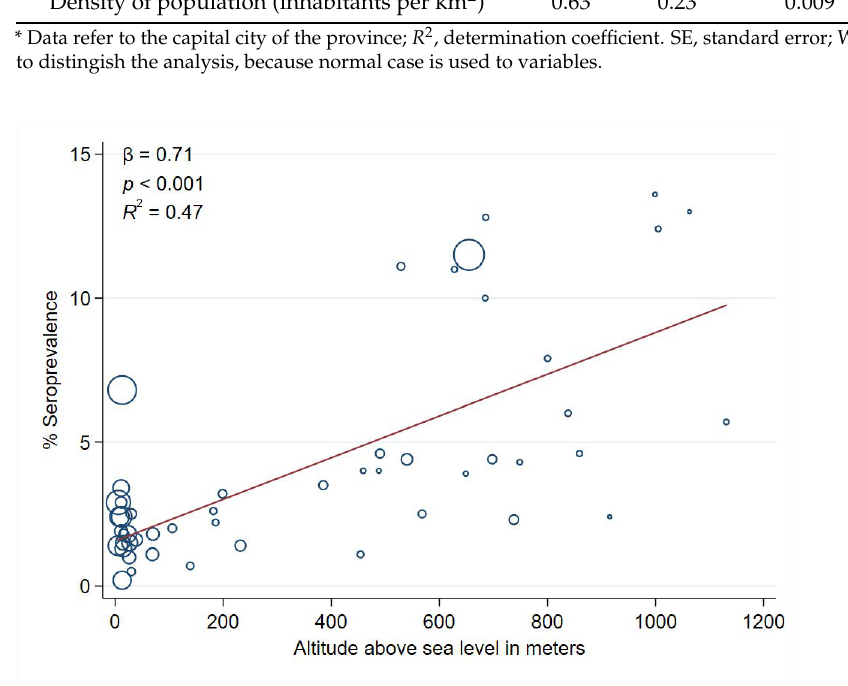
Figure 2. Linear regression analysis of the seroprevalence of IgG antibodies against SARS-CoV-2 as a function of the altitude above sea level in meters by province. The diameter of the circles is proportional to the population density. The seroprevalence was obtained by immunoassay tests in samples collected from 27 April to 11 May 2020, in